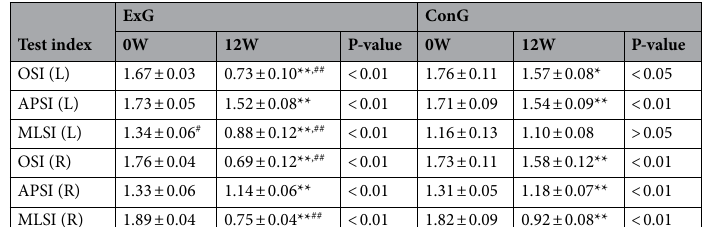
0W was not significant, and at 12W ExG (58.12%) was significantly higher than ConG (43.25%); both ExG and ConG were significantly higher than 0W at 12W. The main effect of FRDC indicator group was not significant (F = 0.012, P = 0.915, ES = 0.001), the main effect of time was significant (F = 64.494, P < 0.001, ES = 0.822), and the interaction effect of time and group was not significant (F = 1.395, P = 0.257, ES = 0.091). The main effect of BLDC indicator group was significant (F = 31.586, P < 0.001, ES = 0.693). The main effect of time was significant (F = 30.626, P < 0.001, ES = 0.686) and the interaction effect between time and group was significant (F = 8.803, P = 0.01, ES = 0.386). Due to the significant interaction effect, further single effect analysis was performed and the difference between ExG (36.50%) and ConG (35.51%) at 0W was not significant and at 12W ExG (51.75%) was significantly higher than ConG (40.12%); ExG was significantly higher than 0W at 12W. The main effect of BRDC indicator group was significant (F = 54.506, P < 0.001, ES = 0.796). The main effect of time was significant (F = 41.750, P < 0.001, ES = 0.749) and the interaction effect between time and group was significant (F = 28.940, P < 0.001, ES = 0.674). Due to the significant interaction effect, further simple effect analysis was performed and the difference between ExG (50.37%) and ConG (47.62%) at 0W was not significant, and at 12W ExG (68.25%) was significantly higher than ConG (49.25%); ExG was significantly higher than 0W at 12W. The main effect of LOST indicator group was not significant (F = 0.063, P = 0.45, ES = 0.041). The main effect of time was significant (F = 65.590, P < 0.001, ES = 0.824) and the interaction effect between time and group was significant (F = 11.099, P = 0.005, ES = 0.442). Due to the significant interaction effect, further simple effect analysis was performed and the difference between ExG (98.63 s) and ConG (94.37 s) at 0W was not significant and both ExG and ConG were significantly higher than 0W at 12W. Table 5. To ensure the pre-test level of SLST in subjects in the ExG and ConG, we conducted an independent samples t test and found no significant difference between the ExG and ConG (P > 0.05). After 12 weeks of training, we conducted a paired samples t test on the pre-test and post-test results of subjects in the ExG and ConG, and found that the pre-test and post-test in the ExG differed significantly (P < 0.01), and the MLSI (L) index differed significantly (P < 0.05) only in the ExG, indicating that the jump rope training improved single-leg stability (SLST) in subjects in the ExG compared to the ConG played a more effective role. Table 6. We performed a 2 (group: ExG, ConG) × 2 (time: 0w, 12w) repeated measures ANOVA on the subject’s single leg stability test (SLST). The results showed that. OSI (L) indicators had significant group main effects (F = 369.088, P < 0.001, ES = 0.963), significant time main effects (F = 270.854, P < 0.001, ES = 0.951), and significant time and group interaction effects (F = 121.847, P < 0.001, ES = 0.897). Due to significant interaction